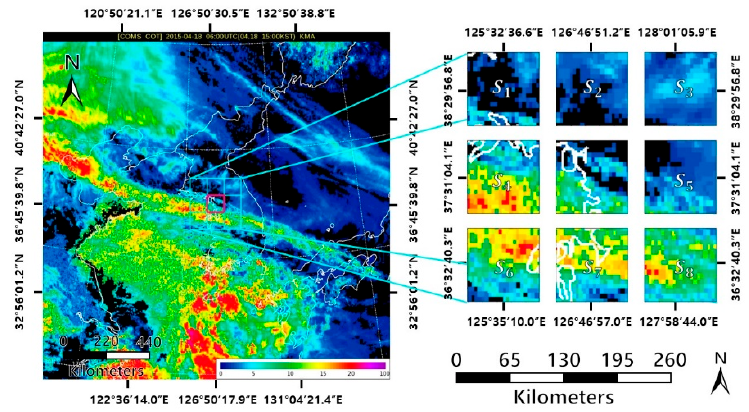
Figure 5. An exemplary satellite image of the Cloud Optical Thickness with sub ROI.